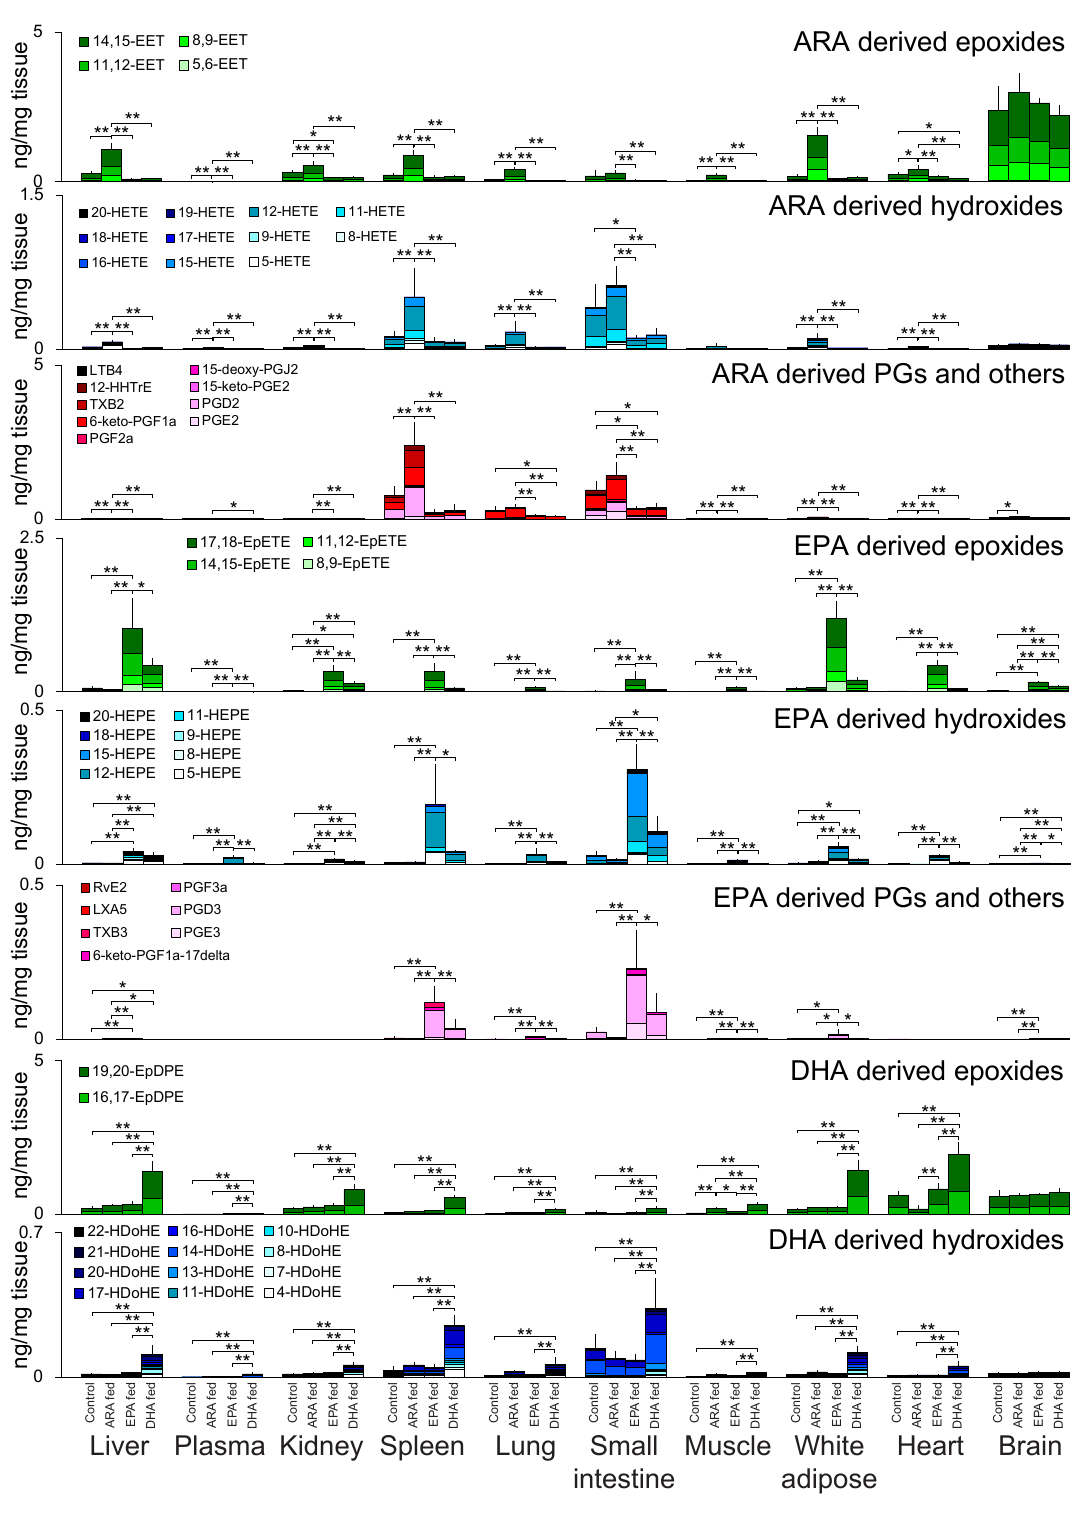
Figure 3. Oxylipin profiles in mouse tissues under each dietary condition. The total amounts of monoepoxides, hydroxides, and cyclized oxidized fatty acids including prostaglandins derived from ARA, EPA, and DHA are described. The results are given for each tissue in the four groups, i.e., the control, ARA-fed, EPE-fed, and DHA-fed groups. The ratio of oxidized fatty acids in each metabolite group is described by the stacked bar chart. The error bar indicates the standard deviation from the total amount values, and the statistical significance was evaluated by Tukey’s testing (* P < 0.05 and ** P < 0.01) where one-way ANOVA showed the statistical significance among groups ( P < 0.05). For plasma, the y-axis unit becomes ng / µ L plasma instead of ng / mg